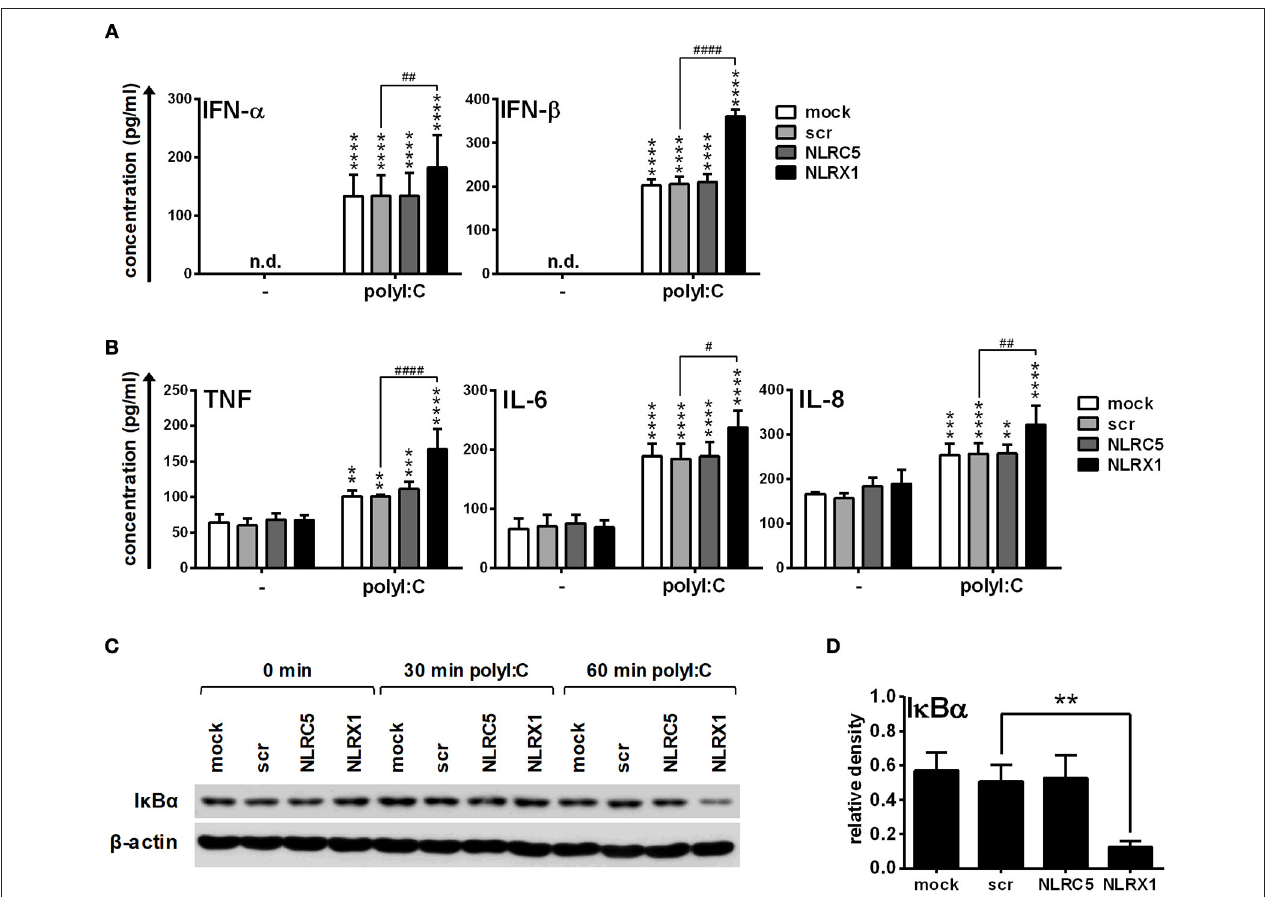
FIGURE 8 | NLRX1 but not NLRC5 controls the RIG-I/MDA5 agonist-induced type I IFN and pro-inflammatory responses in human moDCs. (A–D) moDCs transfected with the indicated siRNAs were stimulated with the RIG-I/MDA5 ligand polyI:C (1 µ g/ml). The protein levels of IFN- α , IFN- β (A) , TNF, IL-6, and IL-8 (B) were detected by ELISA after 24h. (C,D) Kinetics of I κ B α degradation was determined by western blotting. (C) A representative blot is shown. (D) Bar graphs show the relative density of I κ B α measured at 60min of stimulation. (A,B,D) Data are shown as mean ± SD from 4 independent experiments and analyzed using one-way ANOVA followed by Bonferroni’s post-hoc test. ** p < 0.01, *** p < 0.01 **** p < 0.0001 vs. untreated; # p < 0.05, ## p < 0.01, #### p < 0.0001, n.d., not